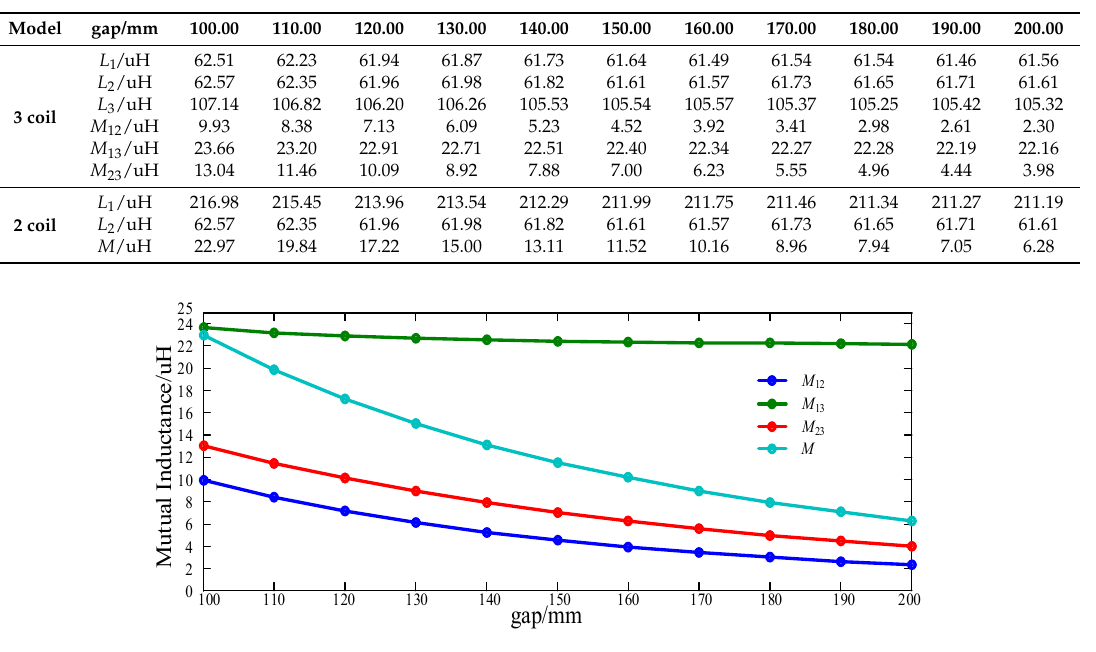
Figure 10. Mutual-inductance Versus Transfer distance.